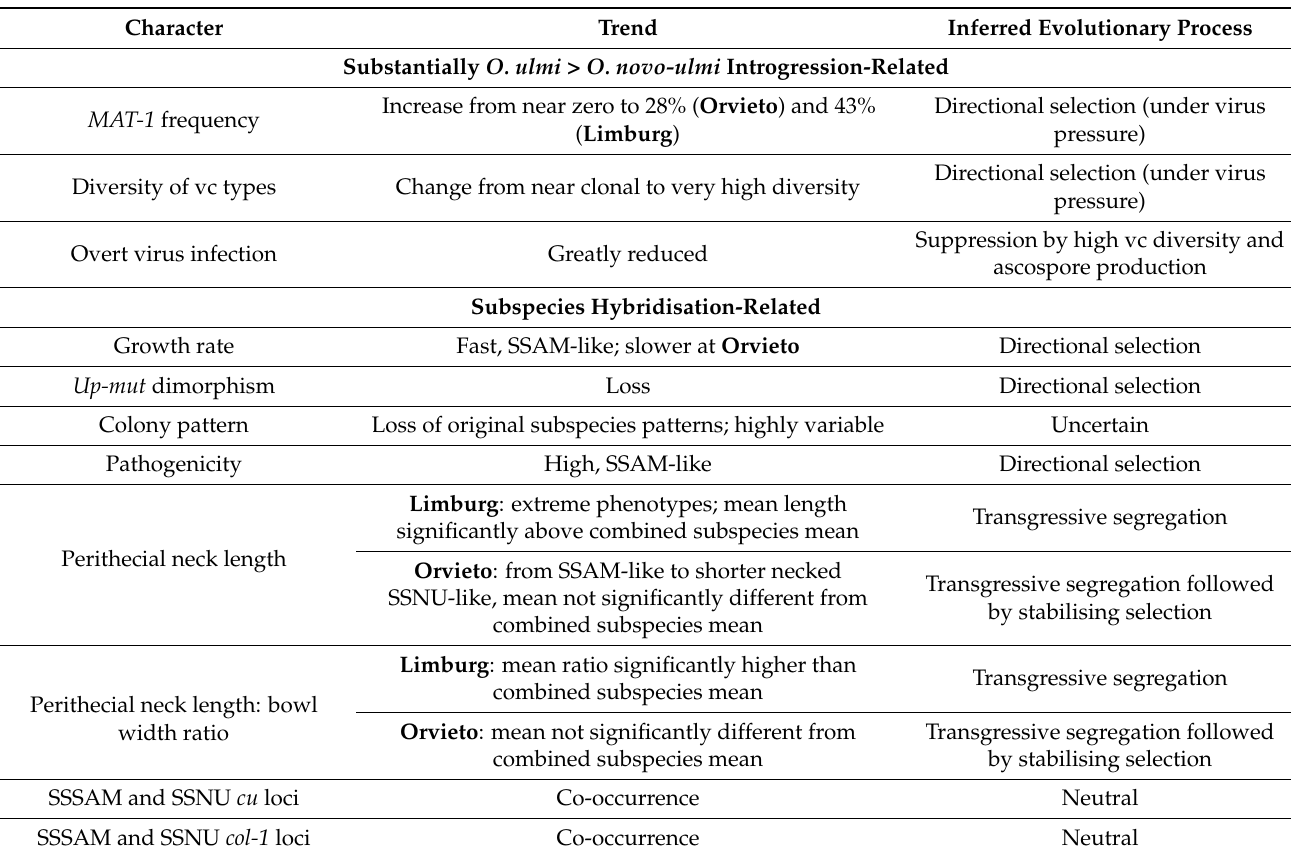
Table 6. Main hybrid trends at Limburg and Orvieto since the early subspecies overlap phase, 1979–1980 1